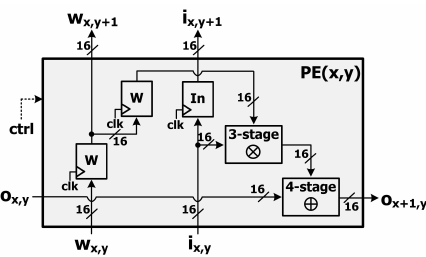
Figure 5. A processing element of systolic array.